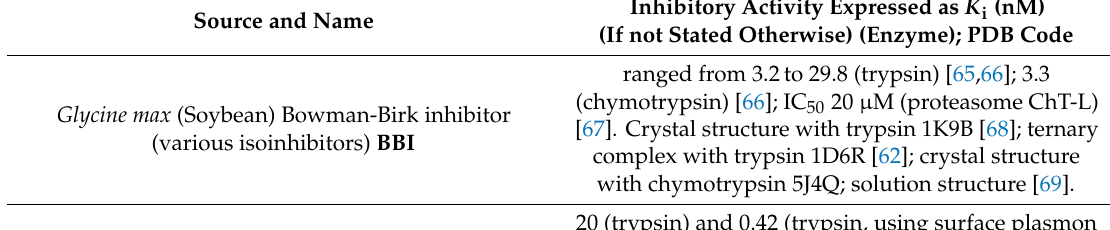
Table 1. The most representative plant BBIs, their origin, inhibitory activities, and PDB codes (if available) of their crystal and / or solution